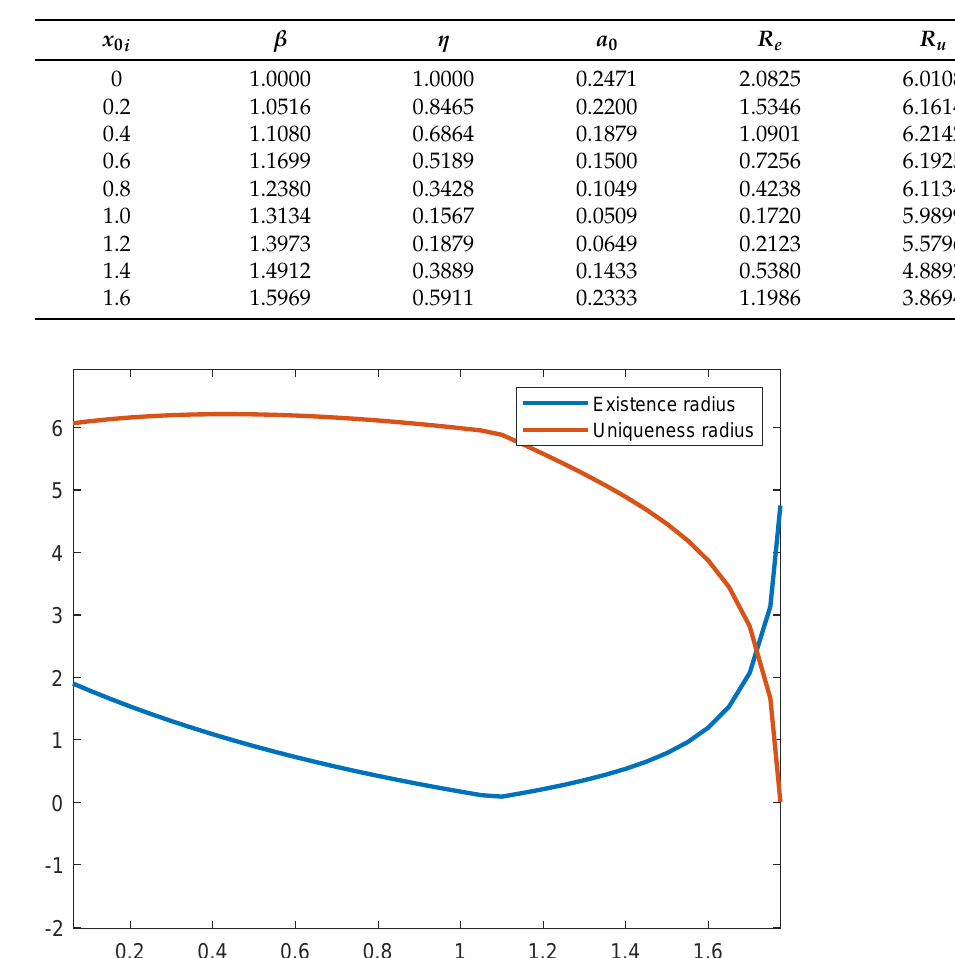
Table 1. Parameters of (16) for different initial estimations.